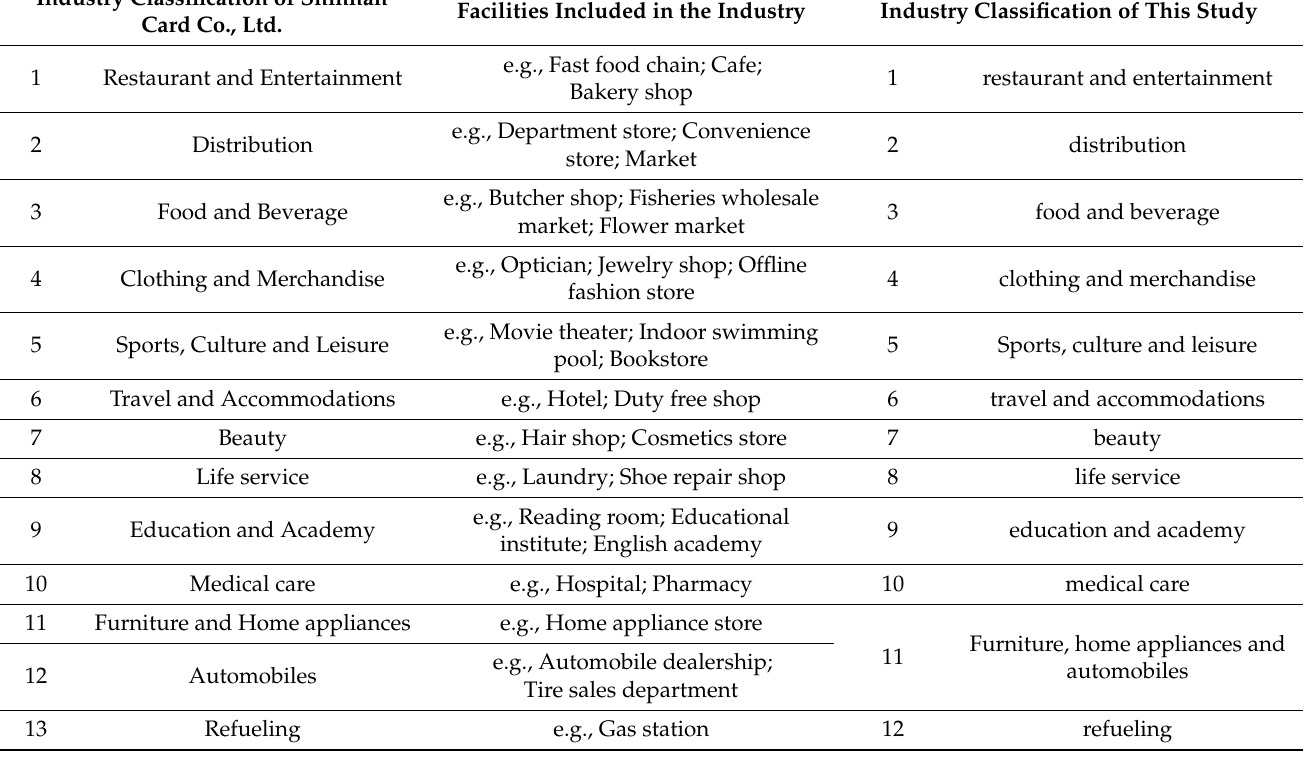
Table 2. Industry classification of Shinhan Card Co., Ltd., and this